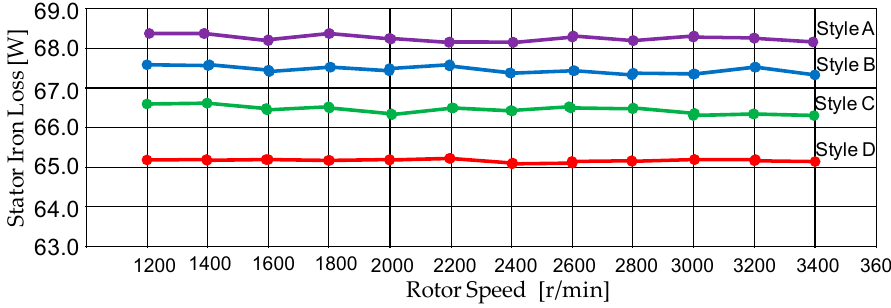
Figure 7. Poly-line line graph comparing stator iron loss for four kinds of SCSCRIMs under several speeds.